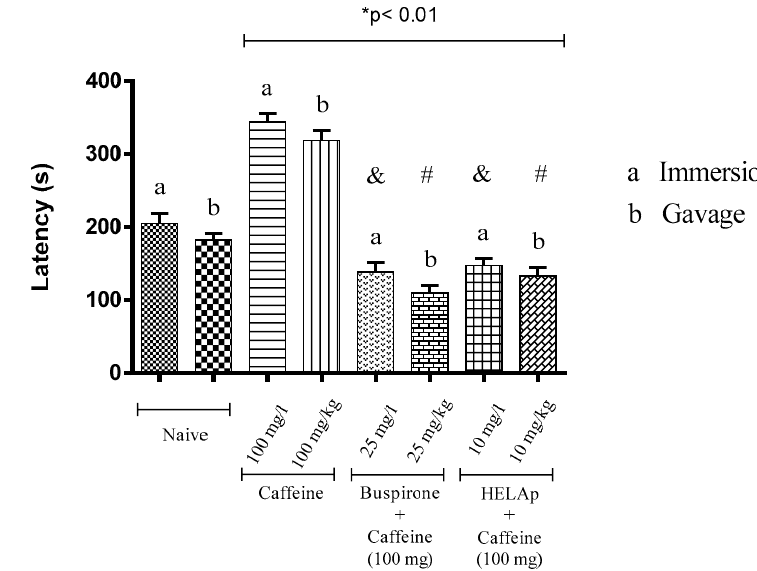
Figure 5. E ff ects of the hydroethanolic extract from A. polystachya , buspirone, and ca ff eine on zebrafish behavior in the scototaxis test (latency) using immersion and oral (gavage) administration. Data are presented as mean ± SEM (n = 4 / groups); * p < 0.01 vs. naive fishes; & p < 0.01 vs. ca ff eine immersion; # p < 0.01 vs. oral ca ff eine administration. Statistical analysis was performed through one-way ANOVA followed by the post-hoc Tukey